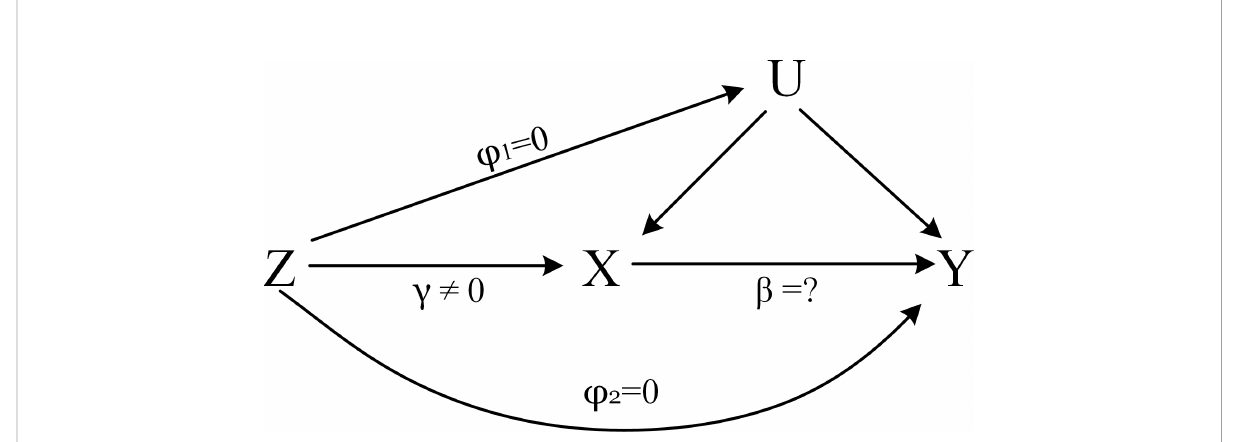
FIGURE 1 The core assumptions of MR. Z represents the genetic instrument (SNPs), X the exposure (BMI, TC, HDL, LDL, and TG), Y the outcome (serum urate), and U denotes the confounders of the relationship of X – Y . Assumptions: 1. Genetic variation is closely related to the exposure of interest, g ≠ 0; 2. Genetic variation has nothing to do with confounding, j 1 = 0; 3. Genetic variation only affects the outcome through X , j 2 =